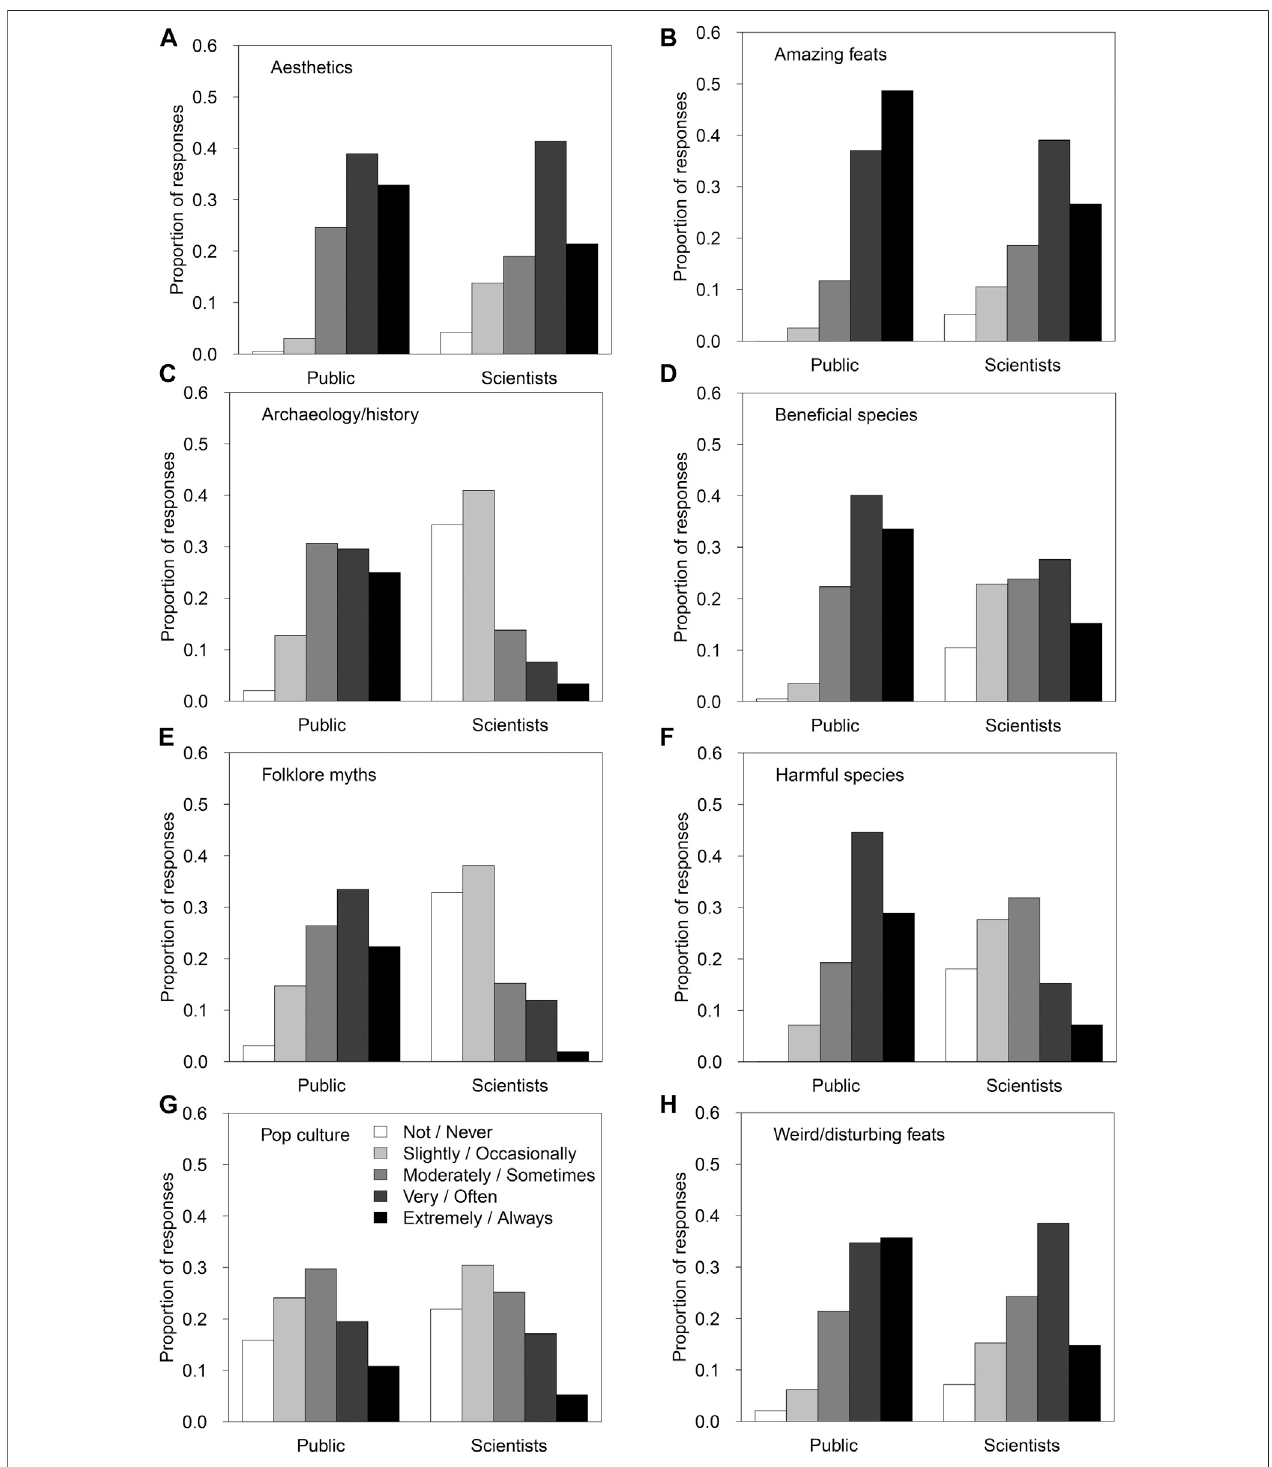
FIGURE 2 | Comparison between public interest and how often scientists use the different approaches to engage the public (Q2.18 and Q1.15, respectively). (A) aesthetics; (B) amazing feats; (C) archaeology/history; (D) bene fi cial species for humankind; (E) folklore/myths, (F) harmful species; (G) pop culture; (H) weird/ disturbing